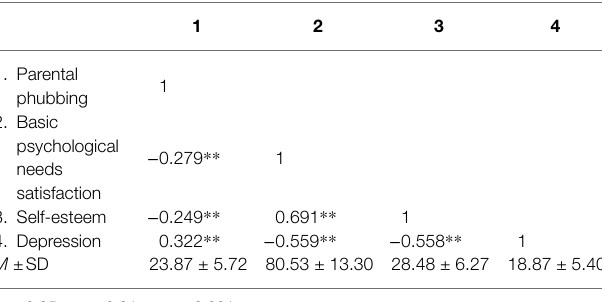
TABLE 1 | Descriptive statistics and correlation of variables.